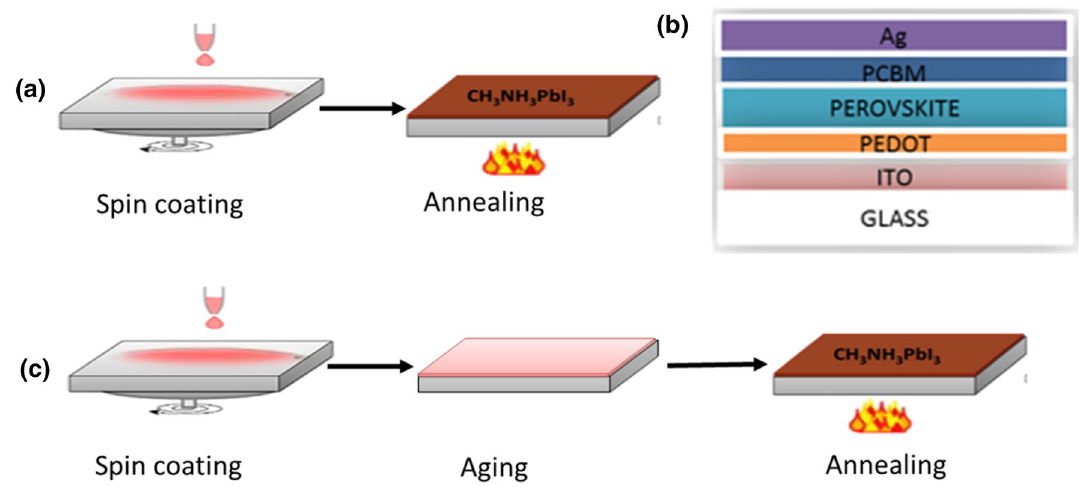
Fig. 1 A schematic representation of the perovskite solar cell fabrication process, a thermal annealing immediately after spin coating, b the architecture of the device, c pre-annealing aging after spin